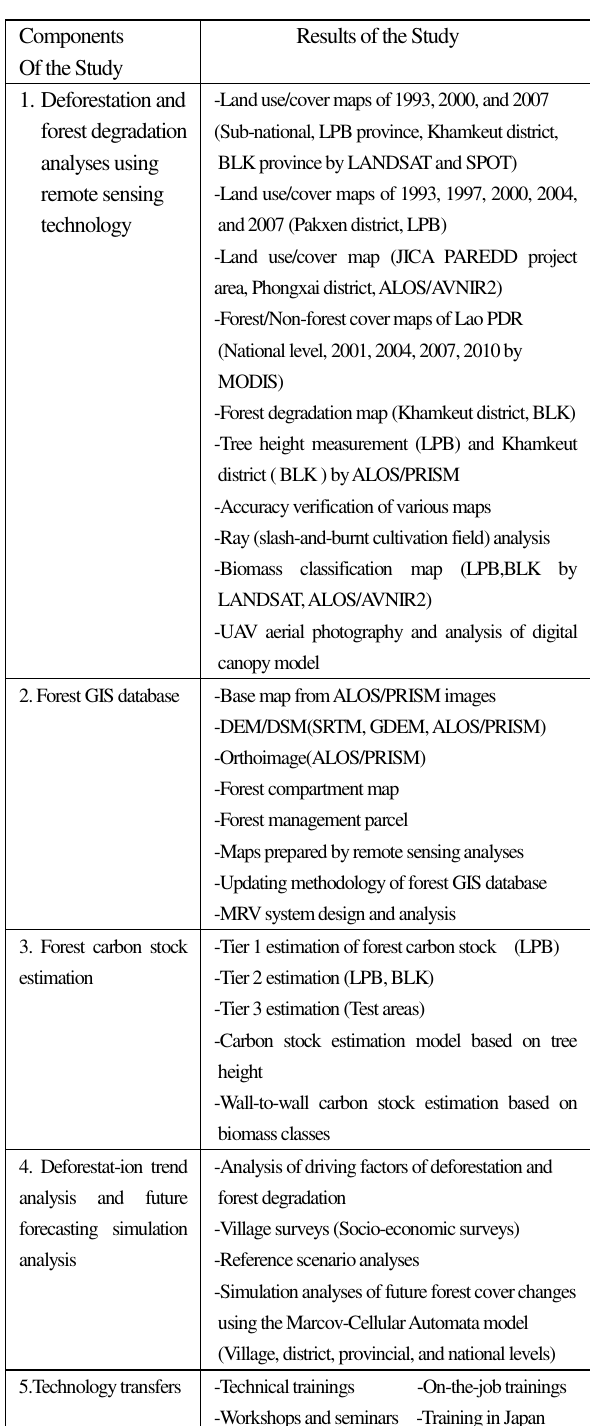
Table 1 Outline and outcomes of the Study